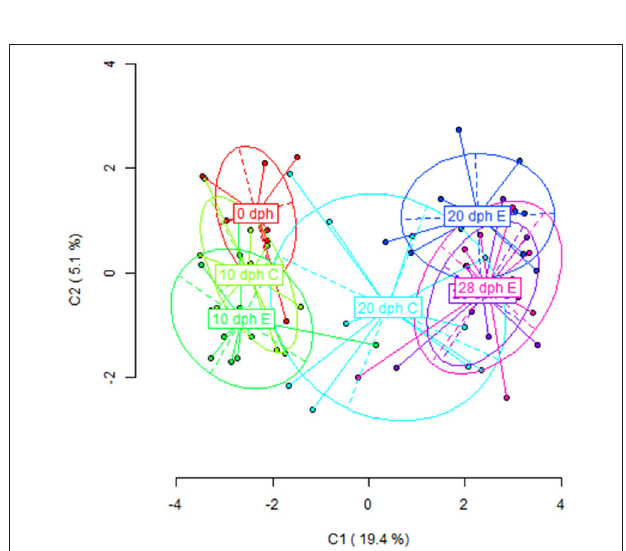
FIGURE 2 | Results from Principal Coordinate Analysis (PCoA) for the HpaII / MspI comparison in all age-diet groups of O. vulgaris paralarvae (C, control diet; E, enriched diet). The first two axes are shown, indicating the percentage of the global variance explained on the corresponding axis. Points were the representation of the paralarvae individuals and the ellipse delimitates the variance of each group (age + diet).